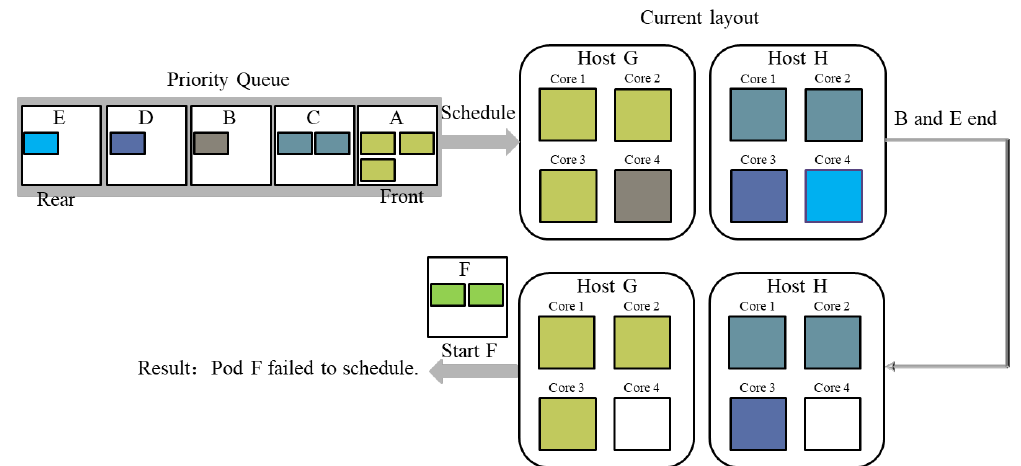
Figure 3. The layout changes, and the platform needs to be dynamically adjusted.